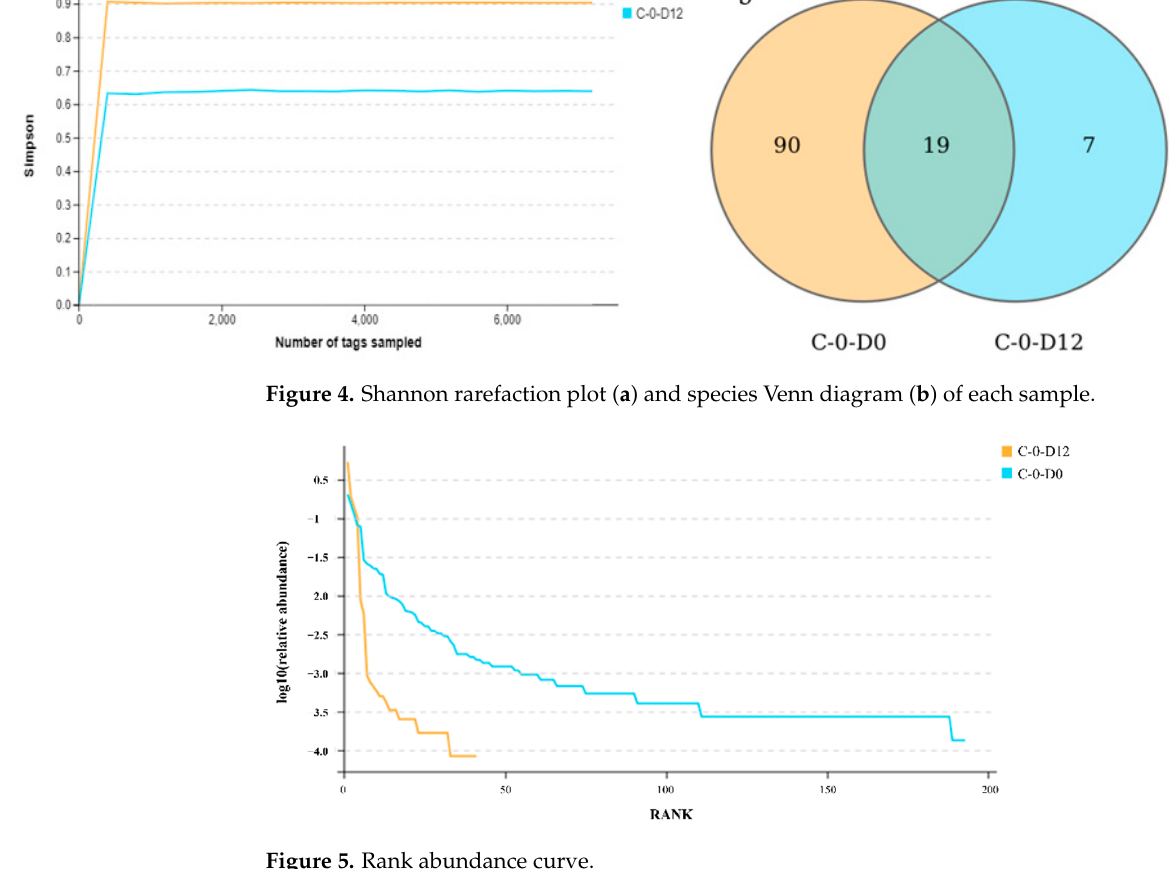
Figure 5. Rank abundance